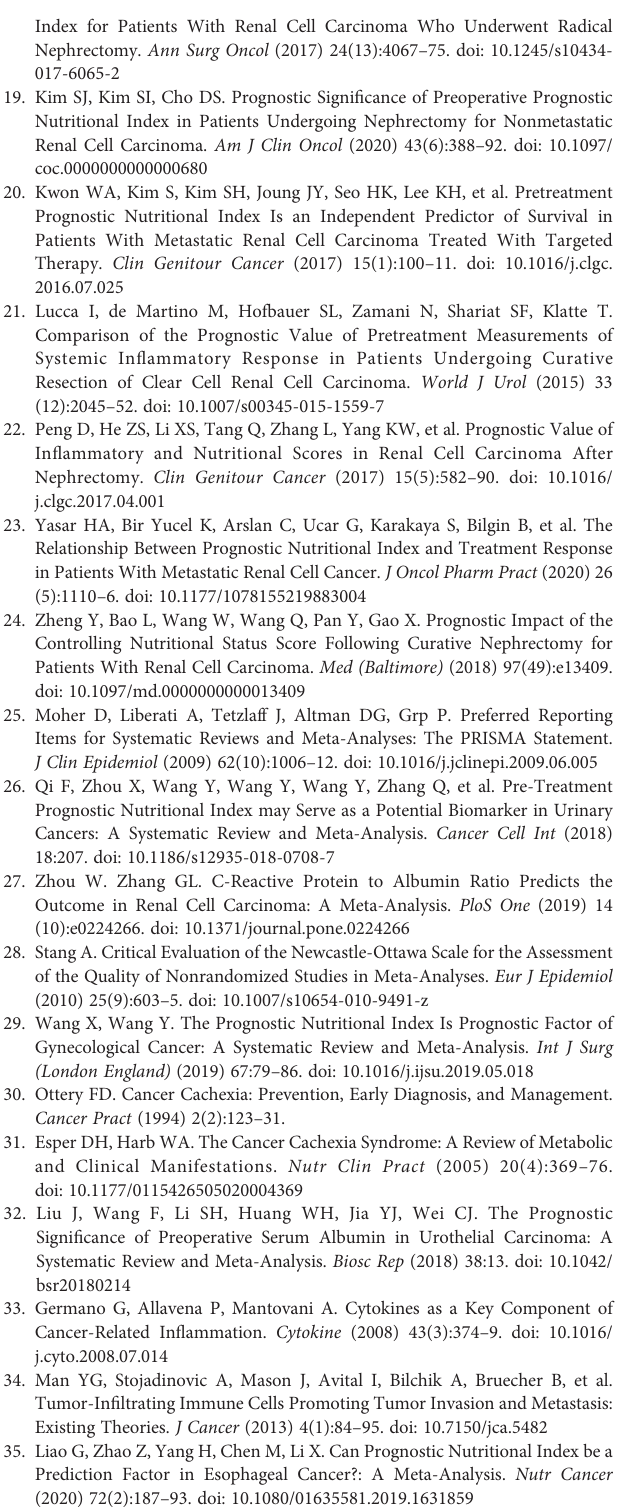
Supplementary Figure 2 | Forest plot examining the association between PNI and PFS/DFS/RFS in patients with RCC. (A) subgroup analysis by various metastatic status of disease; (B) subgroup analysis by histological types of